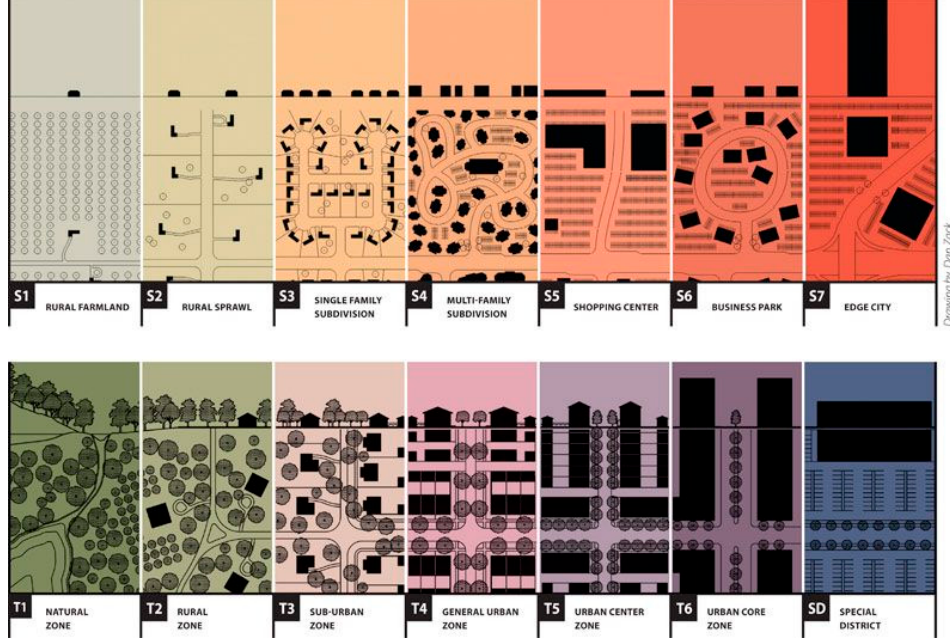
Figure 2. Transect in New Urbanism and in Urban Sprawl; T.Hass, “NewUrbanism and Beyond” Rizzoli, 2002, p. 216.